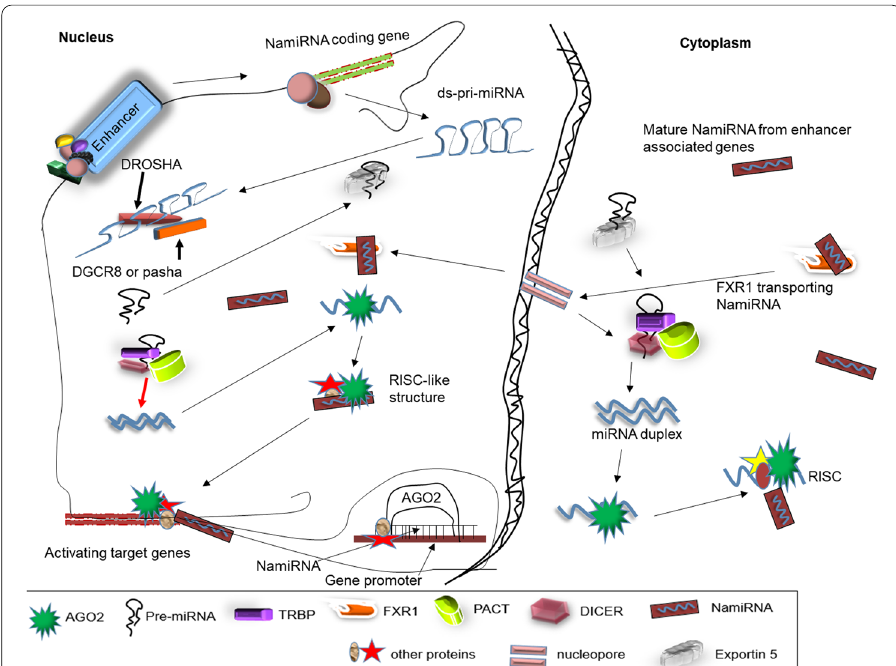
Fig. 2 Biogenesis of NamiRNAs in the nucleus and cytoplasm. Pol II transcribes miRNA coding genes in the same loci as enhancers. MPC process the ds-miRNA into hairpin loop structures. Nuclear AGO2 and RNAi factors Dicer and TRBP process ds-miRNA into NamiRNAs in the nucleus. Alternatively, cytoplasmic produced miRNAs which were transcribed from genes with enhancer associated properties are activated by a RISC-like structure in the cytoplasm. The activated NamiRNAs in the cytoplasm are transported back into the nucleus via FXR1 to perform their activation and enhancing